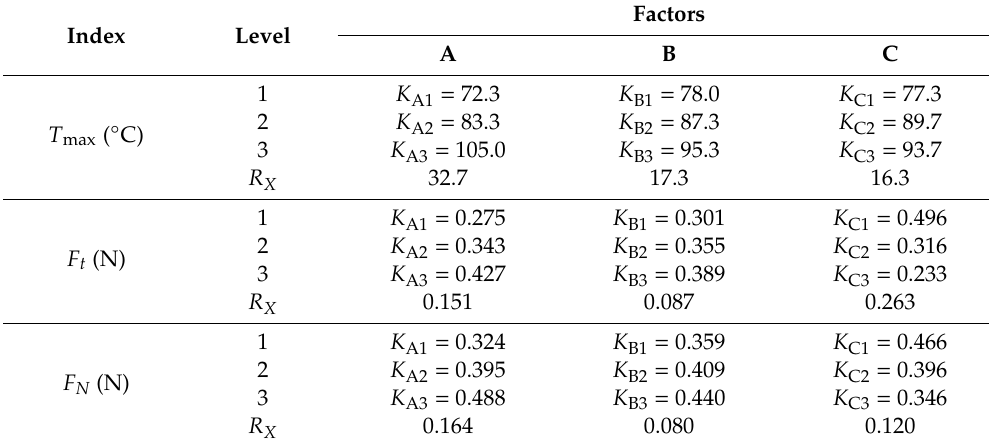
Table 3. Range analysis of orthogonal test